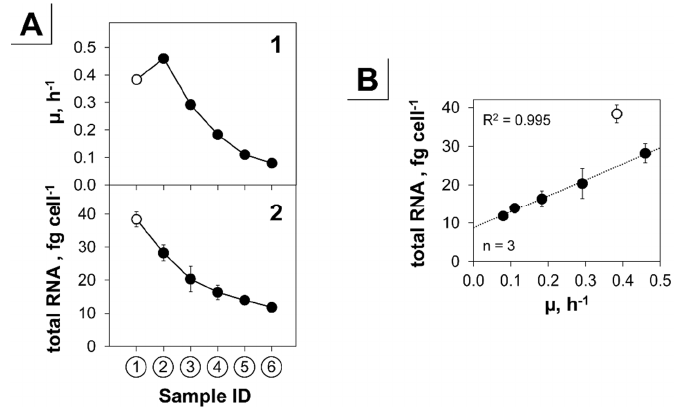
Figure 6. Correlation of total RNA content and growth rate within the triple-phase process. ( A ) The growth rate (µ, 1 ) and the total RNA per cell ( 2 ) is depicted from left to right for the process phases: aerobiosis ( ① , ② ), microaerobiosis ( ③ , ④ , ⑤ ), and anaerobiosis ( ⑥ ; Figure 1A). ( B ) Direct correlation of the total RNA content and the growth rate. Linear regression was calculated neglecting aerobiosis ( 1 (cid:13) , 2 (cid:13) ), microaerobiosis ( 3 (cid:13) , 4 (cid:13) , 5 (cid:13) ), and anaerobiosis ( 6 (cid:13) ; Figure 1A). ( B ) Direct correlation the first sampling point ( ① , open circle). Error bars represent SD of a triplicate experiment. sampling point ( 1 (cid:13) , open circle). Error bars represent SD of a triplicate